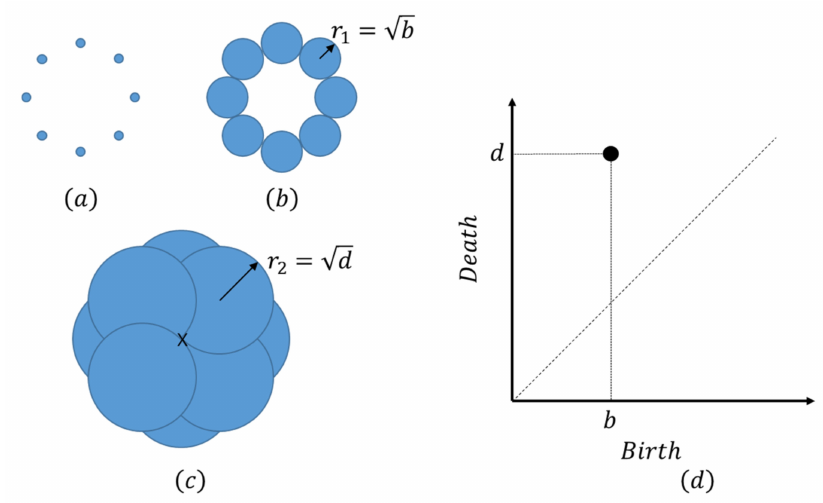
√ b . ( c ) The loop disappears at r = r 2 =